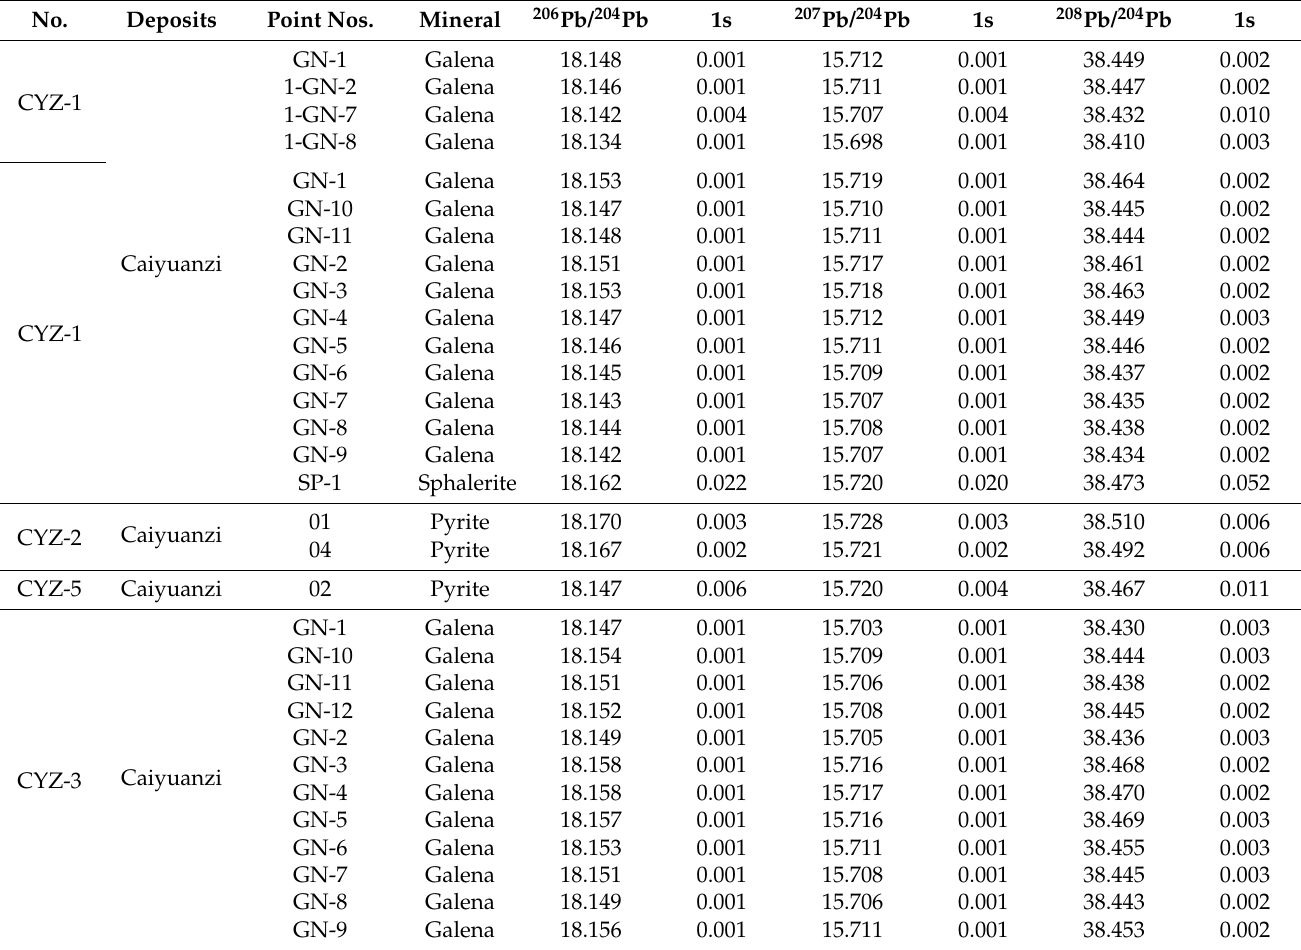
Table 3. In situ Pb isotopes of sphalerite, pyrite, and